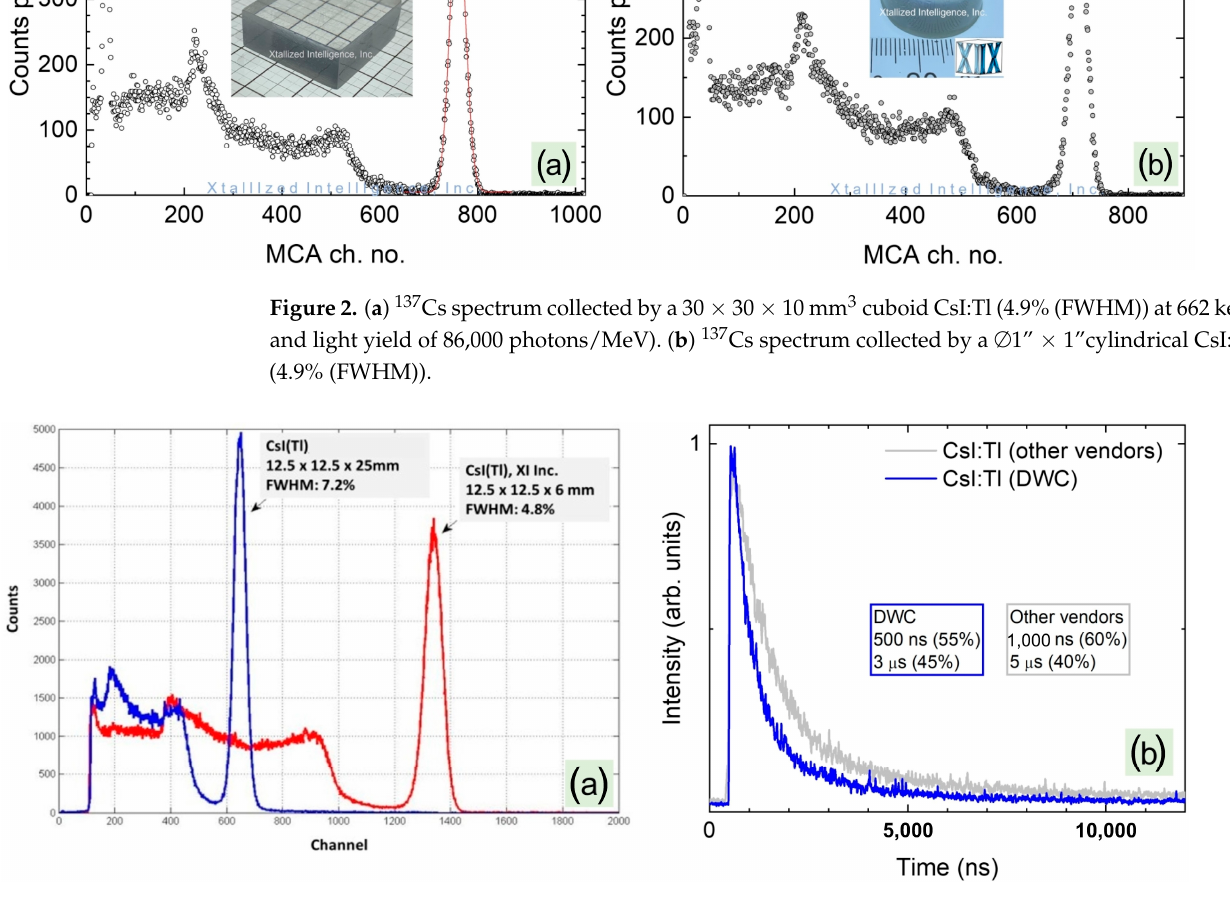
Figure 2. ( a ) 137 Cs spectrum collected by a 30 × 30 × 10 mm 3 cuboid CsI:Tl (4.9% (FWHM)) at 662 keV and light yield of 86,000 photons/MeV). ( b ) 137 Cs spectrum collected by a ∅ 1 ″ × 1 ″ cylindrical CsI:Tl (4.9% (FWHM)).